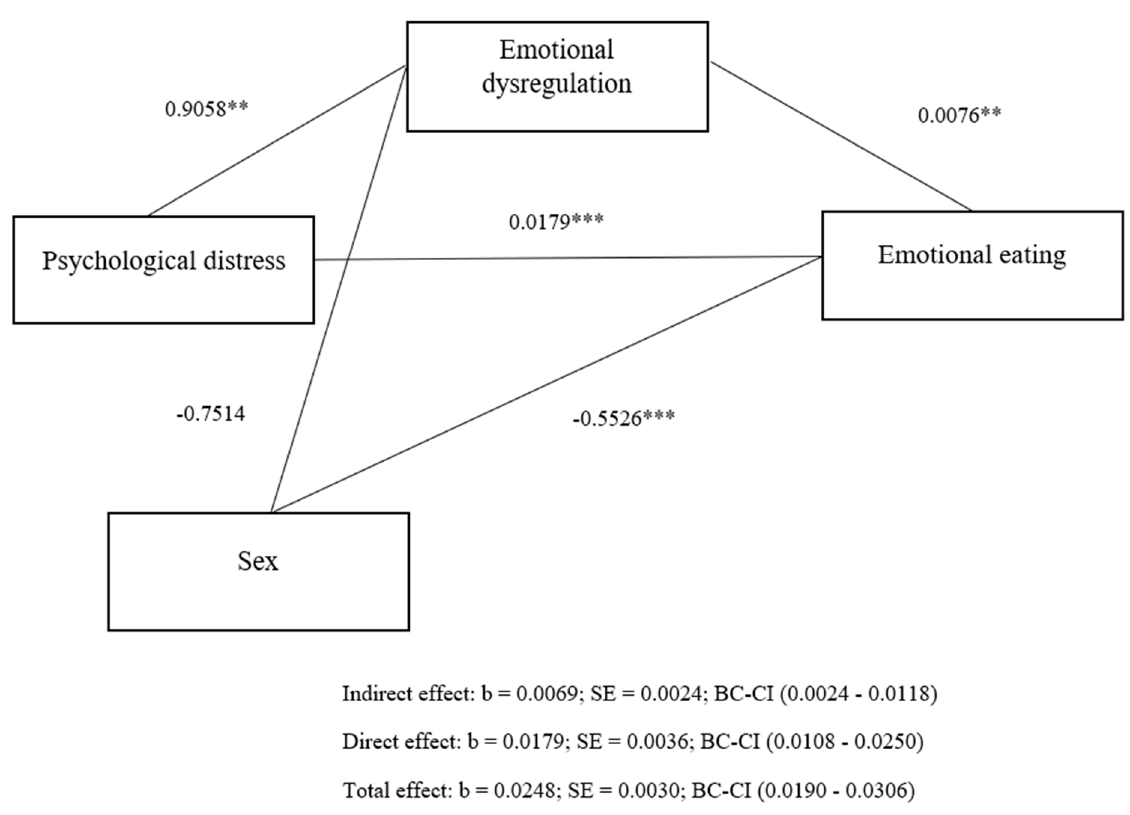
Figure 2. Mediation model for the relationship between psychological distress, emotional, and emotional eating, with sex as a covariate. Note: DASS-21: Depression Anxiety and Stress scale; DERS: Difficulties in Emotional Regulation Scale; EE_DEBQ: Emotional Eating subscale of the Dutch Eating Behavior Questionnaire; ** p < 0.05, *** p < 0.001.